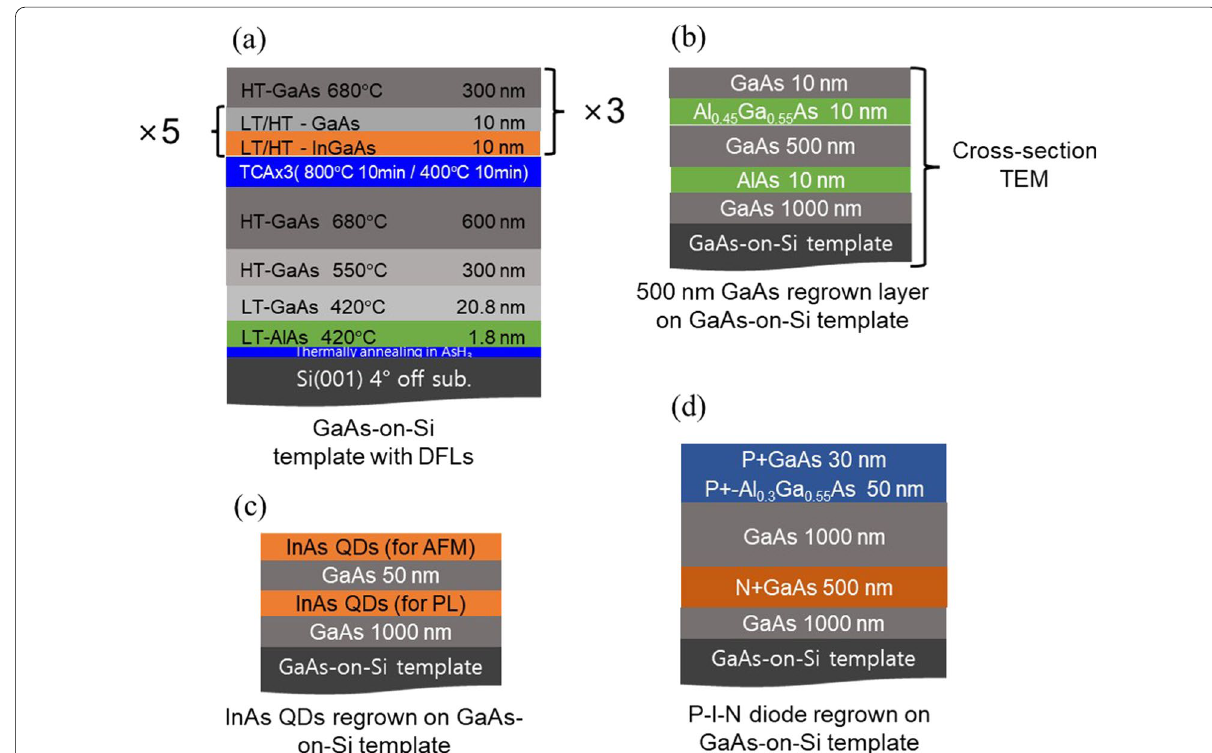
Fig. 1 Schematic structures of GaAs‑on‑Si templates and regrown GaAs buffer and InAs QD layers. The TEM was observed using ( b ) structure and PL was evaluated using both the ( b ) and ( c ) structure, a Schematic structures of GaAs‑on‑Si templates with DFLs, d P‑I‑N diode regrown on GaAs‑on‑Si template